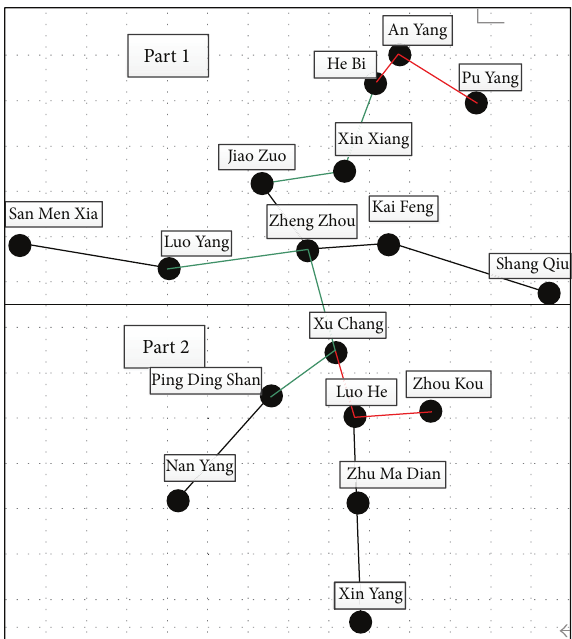
Figure 8: Cities of Henan province.